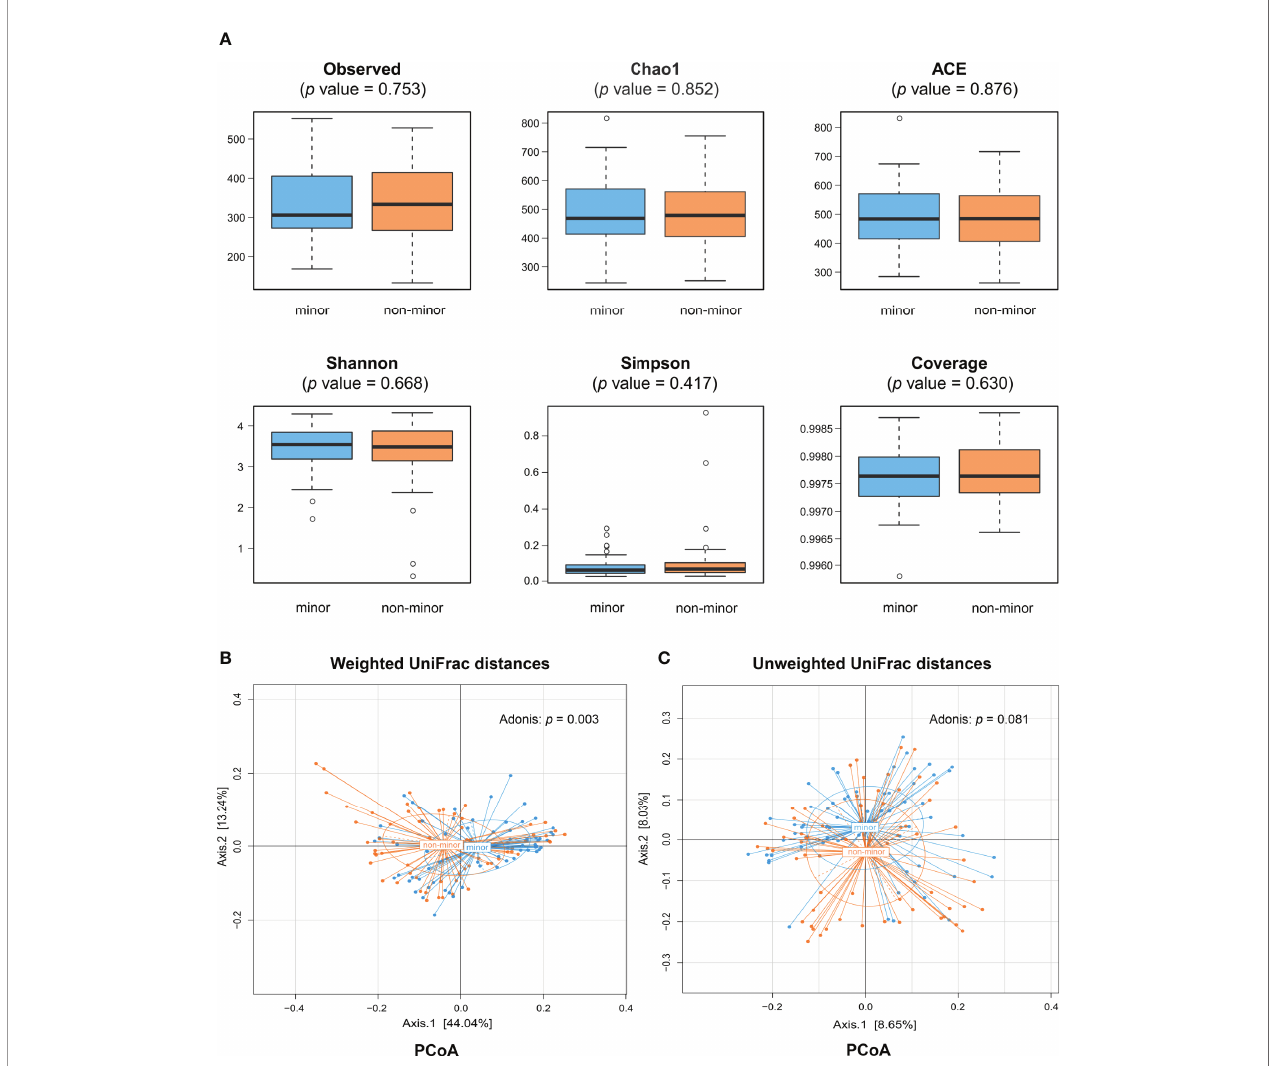
FIGURE 1 | Comparison of gut microbiota diversity between minor stroke patients and non-minor stroke patients. (A) Within-individual ( a ) diversity including observed species, Chao 1 and ACE, Shannon index, Simpson index and coverage index in minor stroke patients (blue) and non-minor stroke patients (orange). Boxes represent the interquartile ranges, lines inside the boxes denote medians, and circles are outliers. Between-individual ( b ) diversity, including principal coordinate analysis (PCoA) based on weighted UniFrac distances (B) and unweighted UniFrac distances (C) , was tested by Adonis. The blue circles represent samples of minor stroke patients and orange circles represent samples of non-minor stroke patients. PCoA, principle coordinate